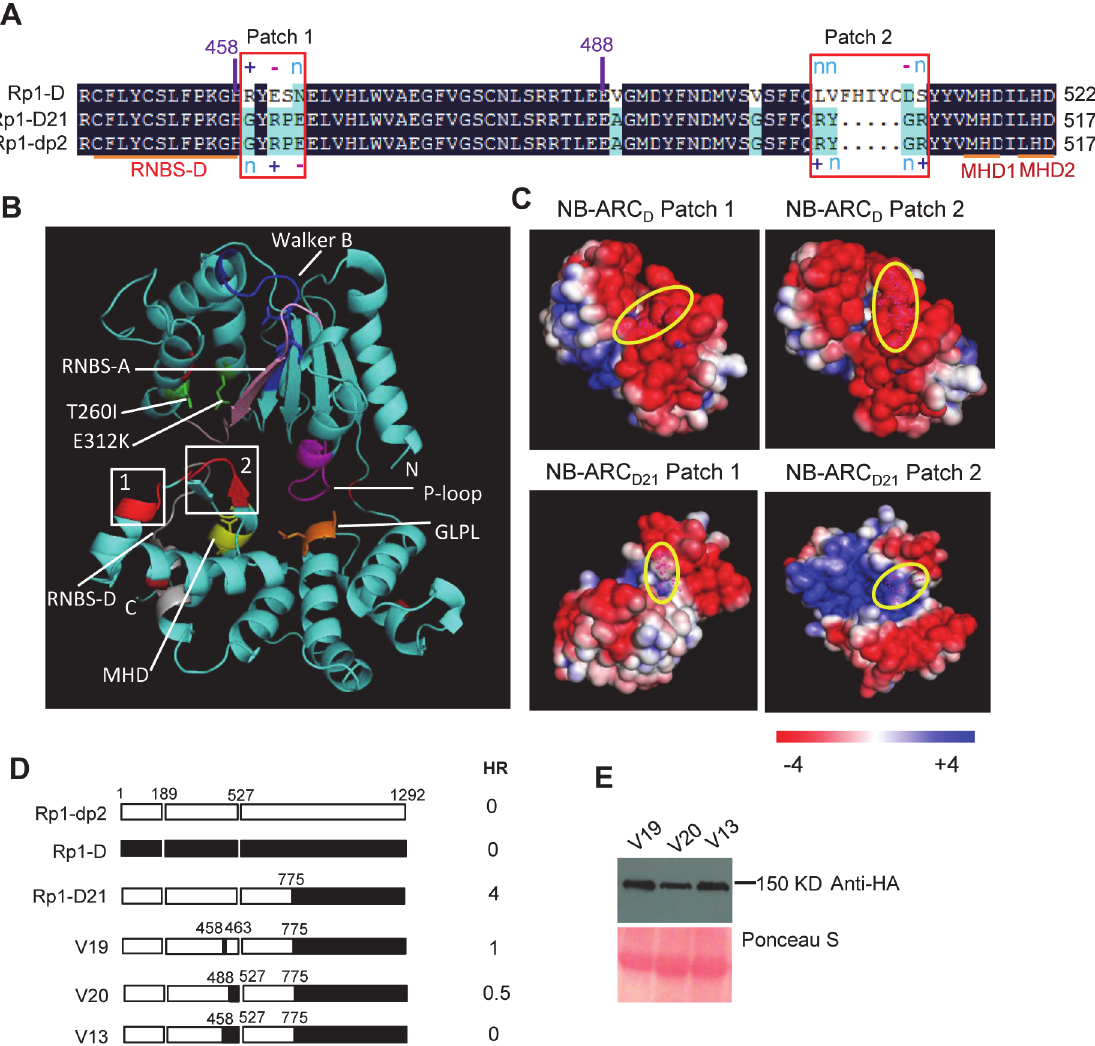
Fig 8. Investigating the function of Patch 1 and 2 from the ARC2 domain for Rp1-D21 autoactivity. (A) Sequence alignment of Rp1-D, Rp1-D21 and Rp1-dp2 in Patch 1 and 2 regions from the ARC domain. Positive (+), negative (-) and neutral (n) charges were labeled. RNBS-D, MHD1 and MHD2 motifs are indicated by orange bars and labeled below the sequences. (B) Homology modeling of NB-ARC D21 based on the crystal structure of APAF1 (PDB: 1z6t). The P-loop, MHD, GLPL, RNBS-A, RNBS-D and Walker B motifs are color-coded in magenta, yellow, orange, pink, green and blue, respectively. Two boxed regions (Patch 1 and 2) are the major polymorphic regions between Rp1-D and Rp1-dp2 and are labeled in red. The positions of the suppressor mutations T260I and E312K identified by EMS mutagenesis are indicated in green. The N- and C-termini are indicated as N and C, respectively. (C) The surface electropotential of NB-ARC D21 and NB-ARC D . The positive and negative charges are indicated in blue and red, respectively. The positions of Patch 1 and Patch 2 are indicated by pink dots in the yellow oval boxes. (D) Schematic diagram and the hypersensitive response phenotype of the constructs indicated. (E) Protein expression was detected by anti-HA antibody at 3 days post-infiltration. Ponceau-S staining of Rubisco subunit was used as loading control. The experiment was repeated three times with the same